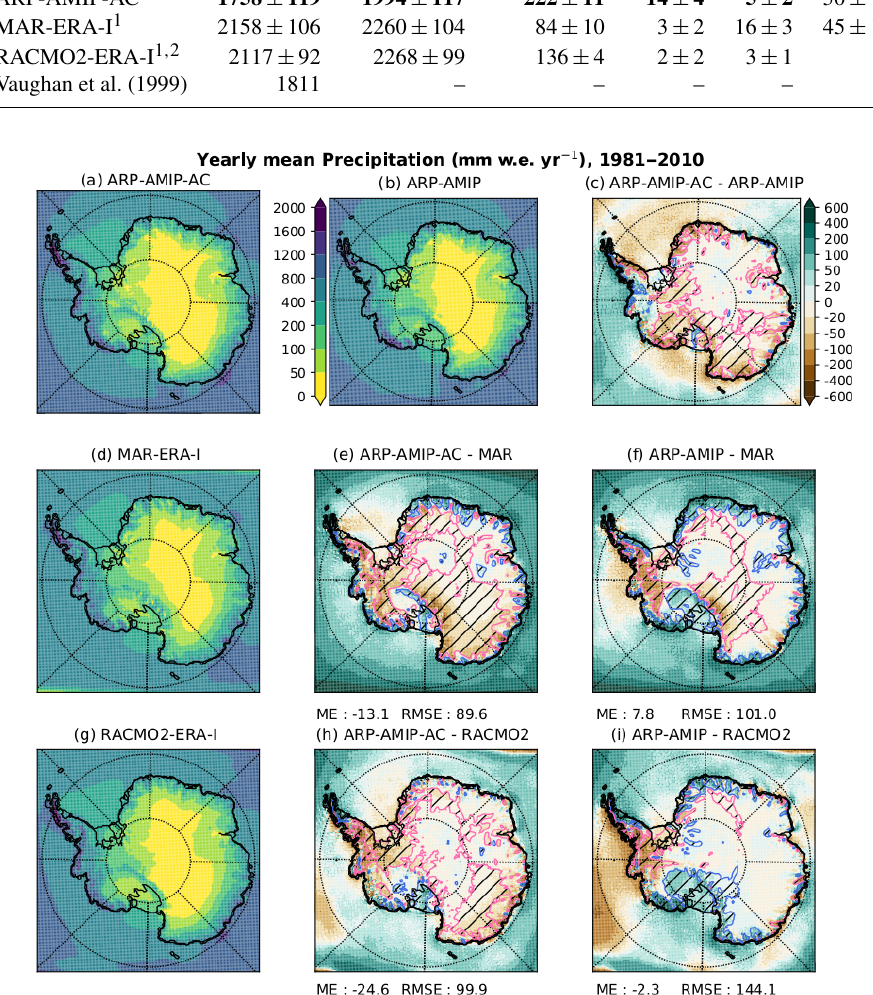
Figure 5. Yearly mean total precipitation (mmw.e.yr − 1 ) for ARP-AMIP-AC (a) , ARP-AMIP (b) , MAR-ERA-I (d) and RACMO2-ERA-I (g) for the reference period 1981–2010. Difference (mmw.e.yr − 1 ) for ARP-AMIP-AC minus ARP-AMIP (c) , ARP-AMIP-AC minus MAR- ERA-I (e) , ARP-AMIP minus MAR-ERA-I (f) , ARP-AMIP-AC minus RACMO2-ERA-I (h) and ARP-AMIP minus RACMO2-ERA-I (i) . Blue (magenta) hatched contour lines represent areas where the positive (negative) difference is larger than 20%. Mean error (ME) and RMSE statistics (mmw.e.yr − 1 ) for the comparison with MAR and RACMO2 are shown below the